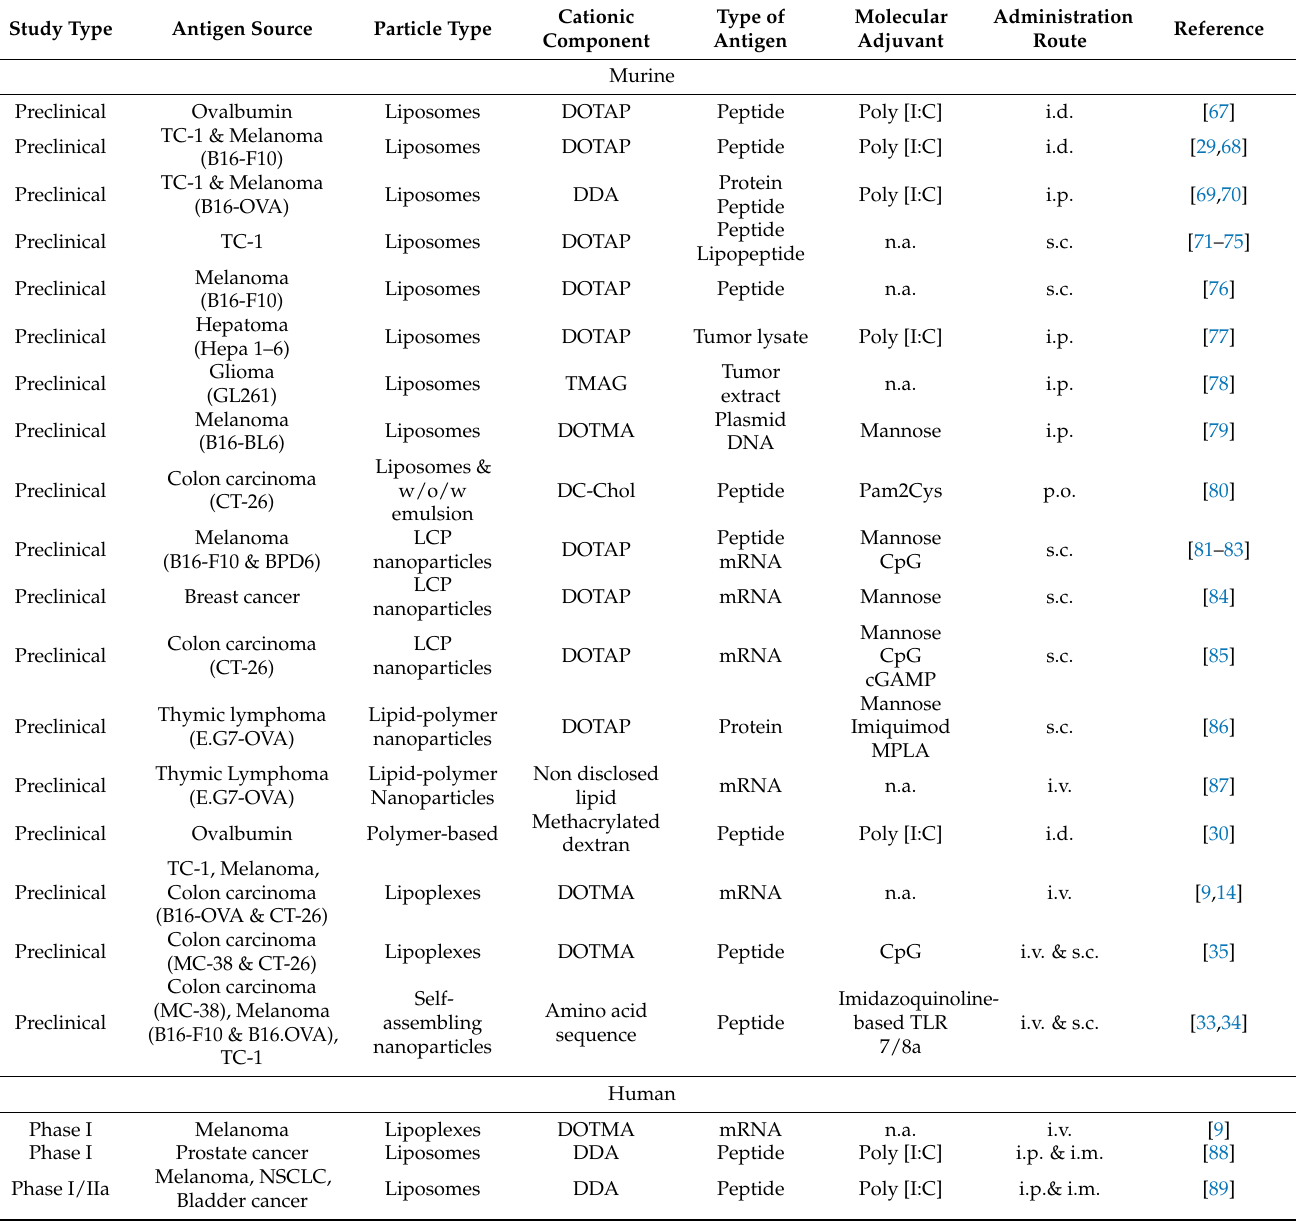
Table 1. Currently reported cationic nanoparticle-based cancer vaccine